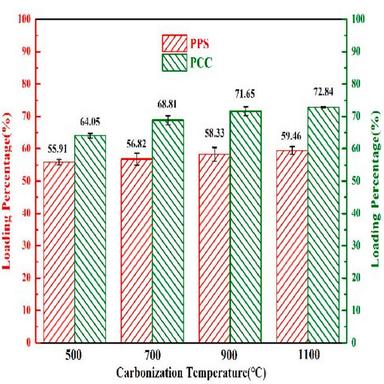
Mass composition of representative PPSs and PCCs.closest to the respective average.